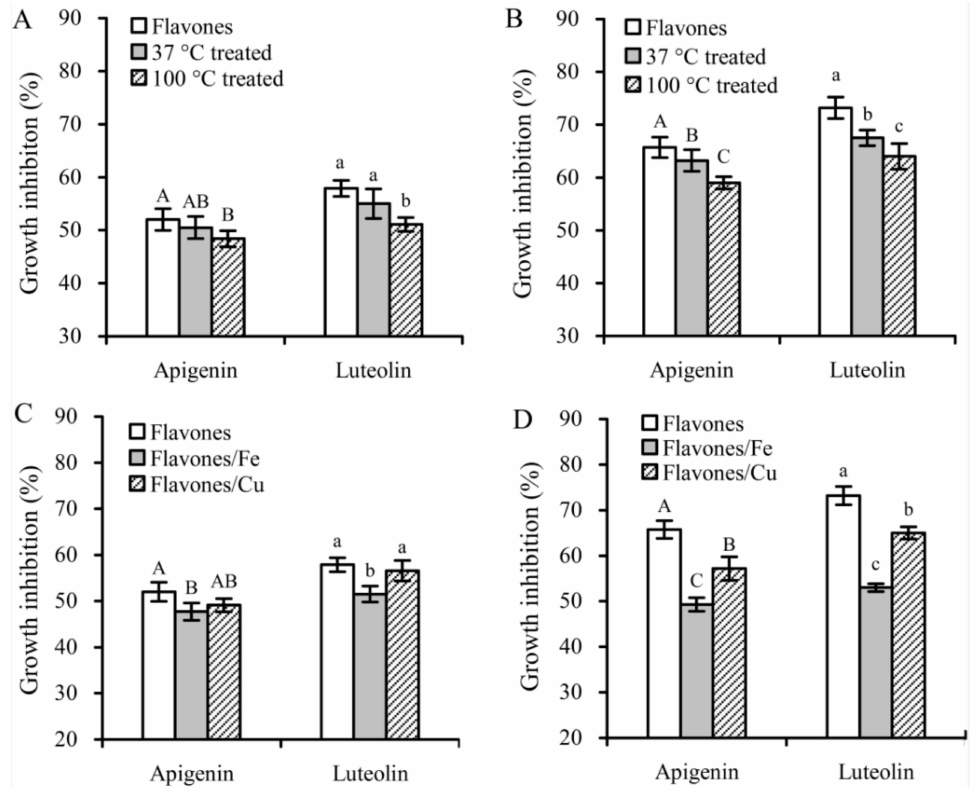
Figure 4. Growth inhibition of 40 µ moL / L flavonols (with or without thermal treatments and Fe / Cu addition) on the Hela cells with treatment times of 24 ( A , C ) and 48 h ( B , D ). Di ff erent capital or lowercase letters above the columns indicate that the means within the same group di ff er significantly according to one-way ANOVA ( p <